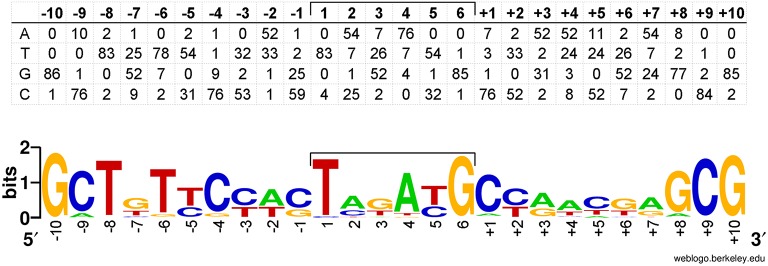
Position-specific scoring matrix derived from the multiple sequence alignment of all target sites used by ISRme5. Eighty-seven target sites and the flanking DNA sequences have been aligned to generate the matrix shown. The sequences compiled are those adjacent to the left (−1 to −10) and right end (+1 to +10) of ISRme5. The central six nucleotides are those that would be duplicated on insertion. A sequence logo was generated from this matrix with WebLogo (Crooks et al., 2004).